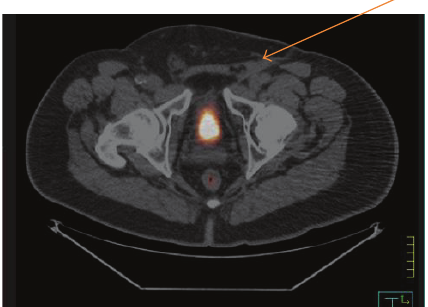
Figure 2: Most recent PET-CT revealing no evidence of disease